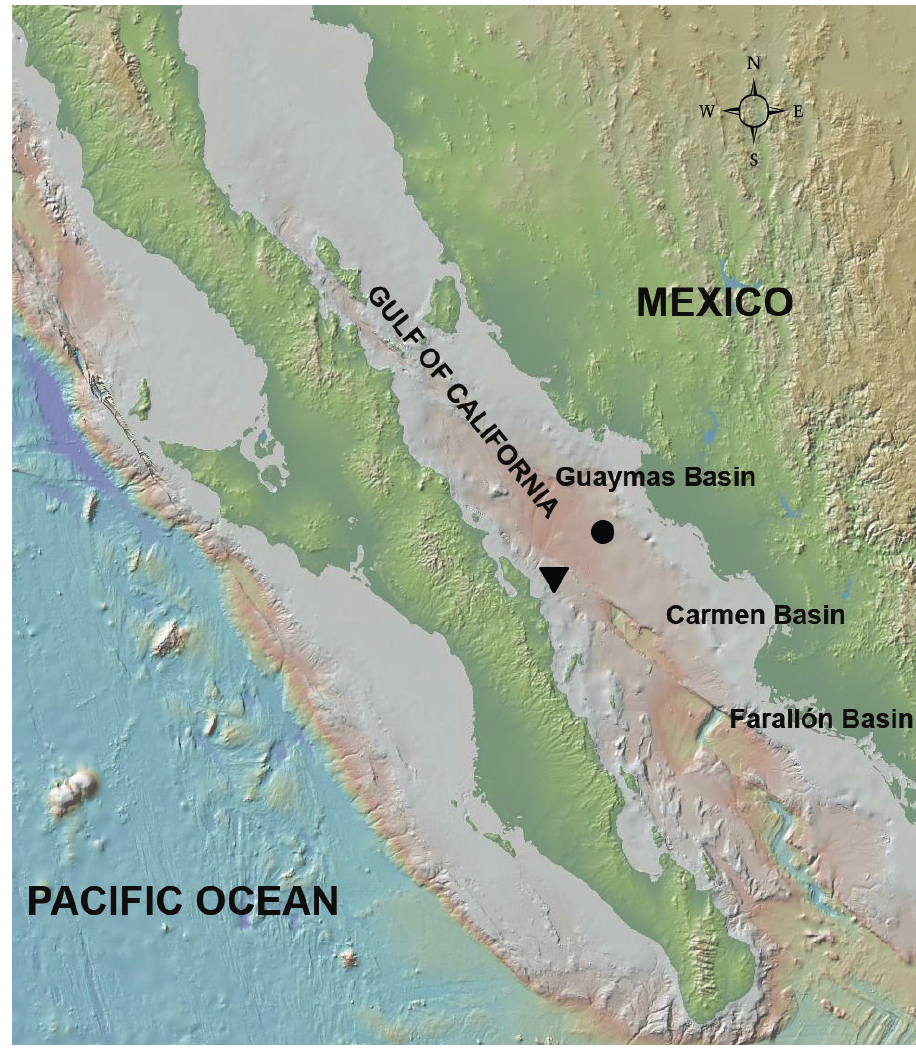
Figure 1. Sampling sites and type localities of Ceratonotus elongatus sp. n. (circle) and Dendropsyllus cali- forniensis sp. n. (inverted triangle). Figure prepared with GeoMapApp (http://www.geomapapp.org/) and the Global Multi-Resolution Topography (GMRT) default basemap (Ryan et al.